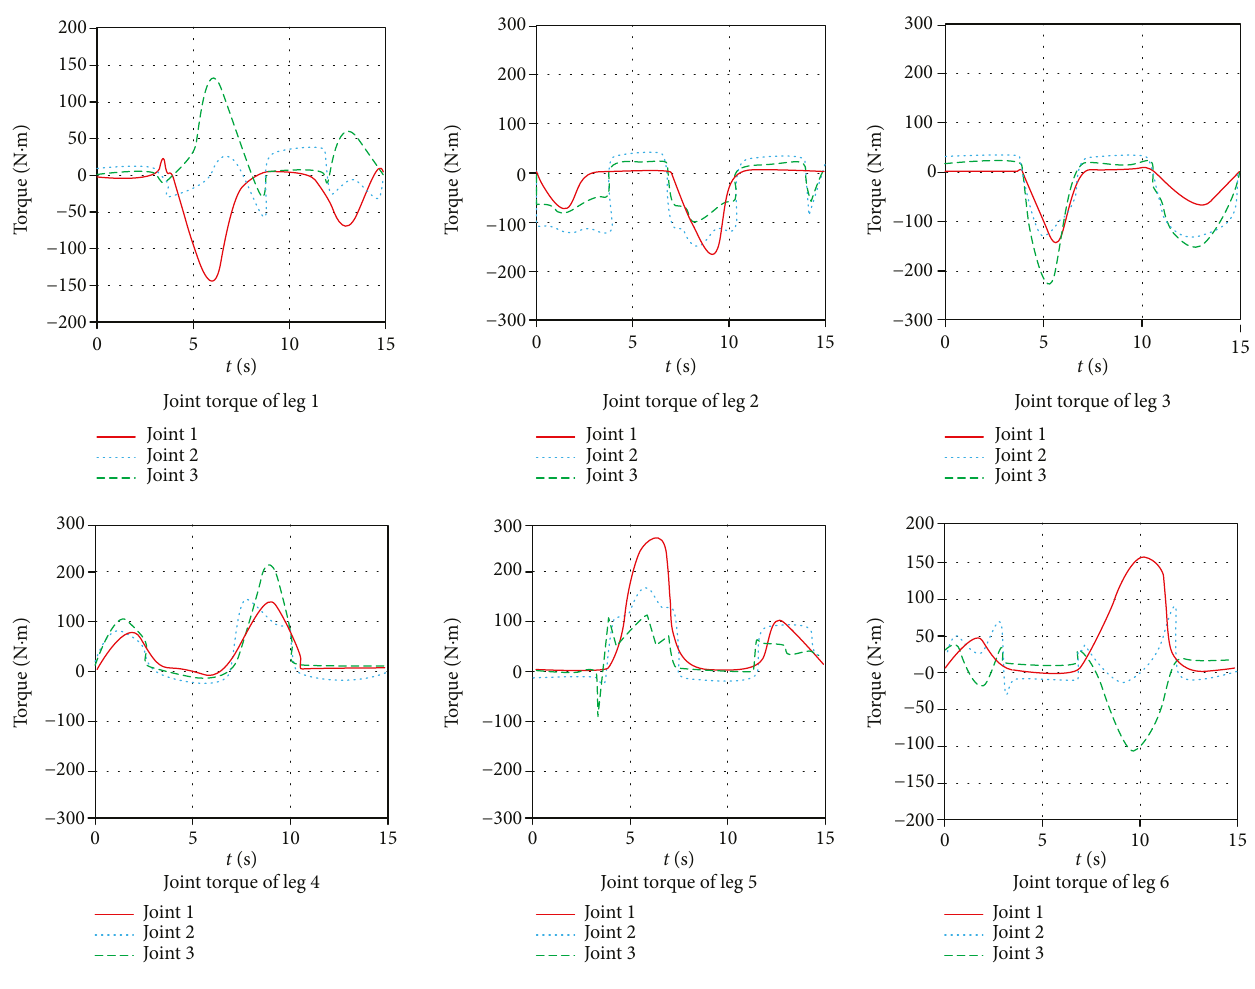
Figure 16: The joint torque change with time in triangular gait.